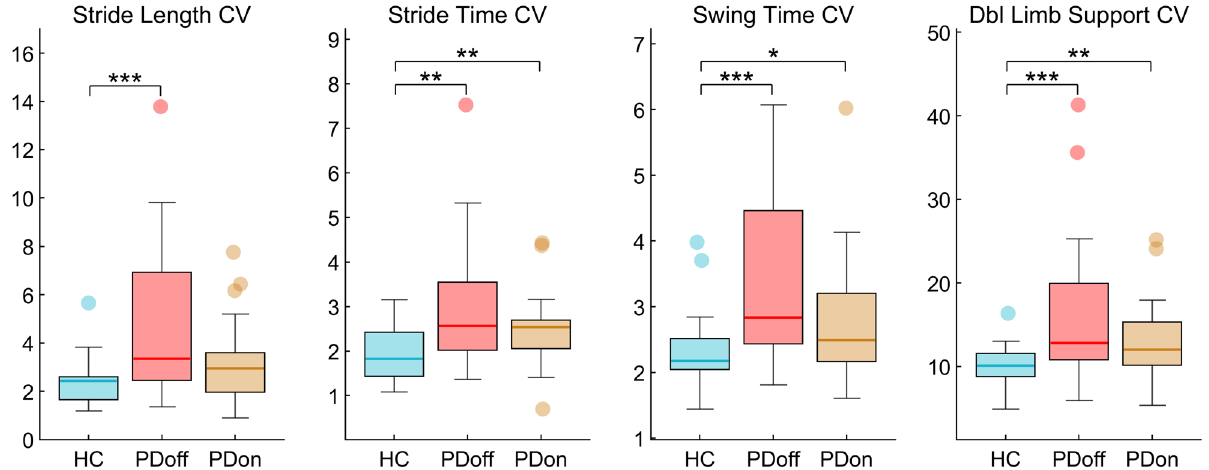
Figure 3. Spatio-temporal analysis of gait. Box plots (see Fig. 1 caption for explanation of box plot) of coefficients of variability (CV) of spatio-temporal parameters. Healthy controls (HC), individual